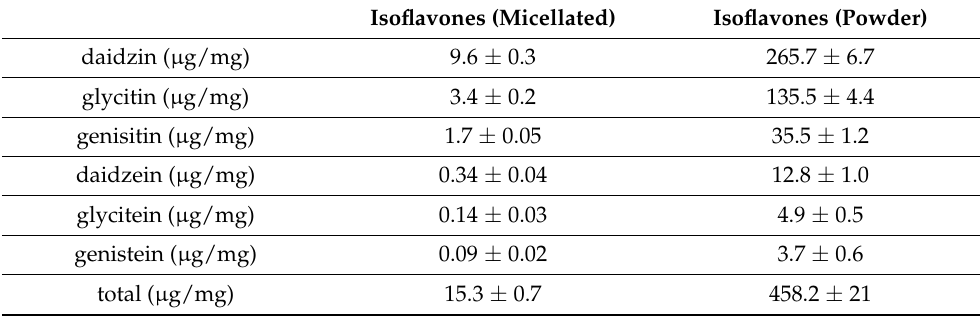
Table 3. Content of isoflavone glycosides and aglycones in micellated and CD-complexed